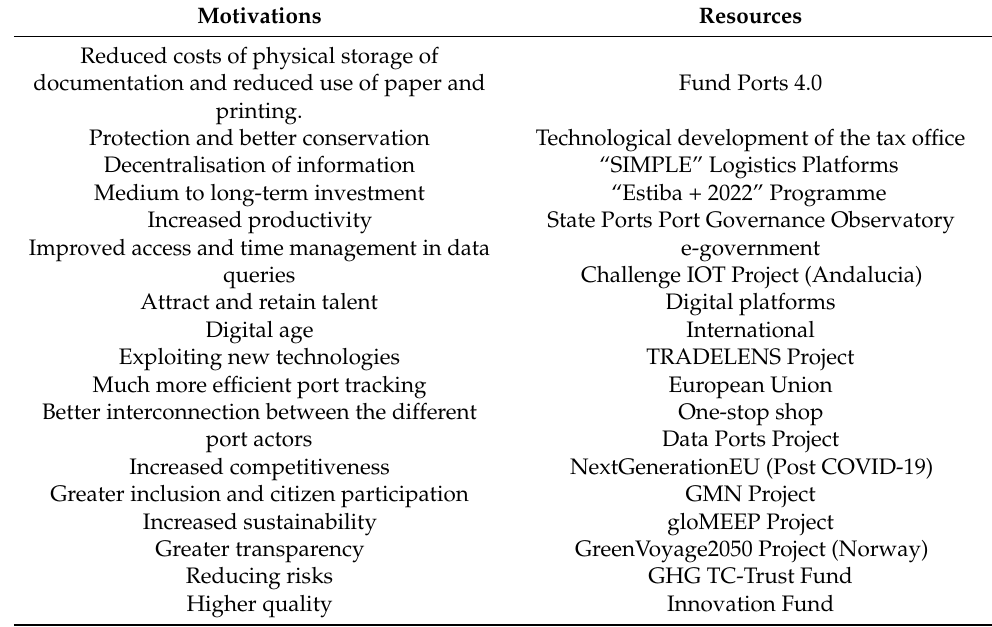
Table 1. BOT motivations and resources. Source: own